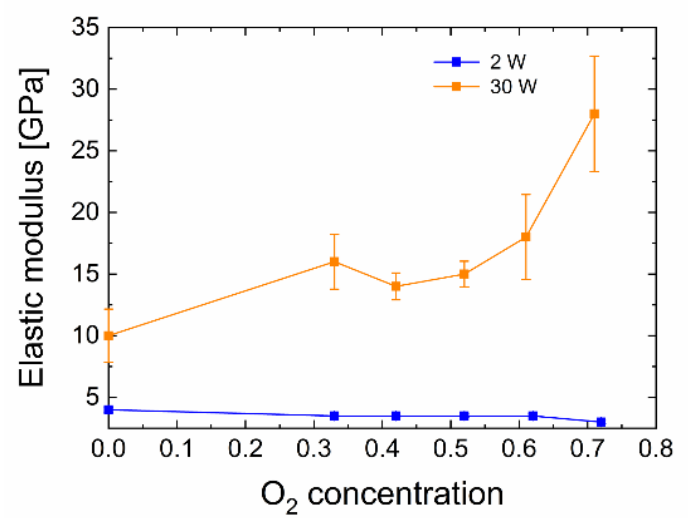
Figure 8. Influence of the oxygen concentration on the elastic modulus.